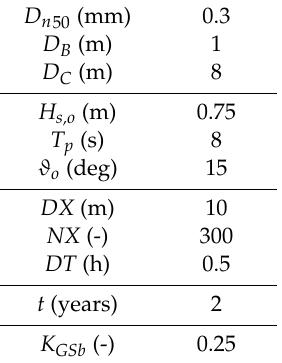
Table 2. Selected input parameters.